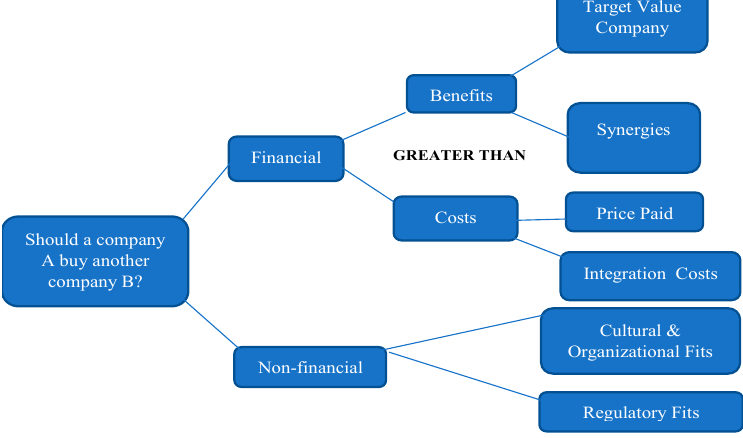
Figure 1. Factors of dependence for mergers and acquisitions (M&As) between firms .